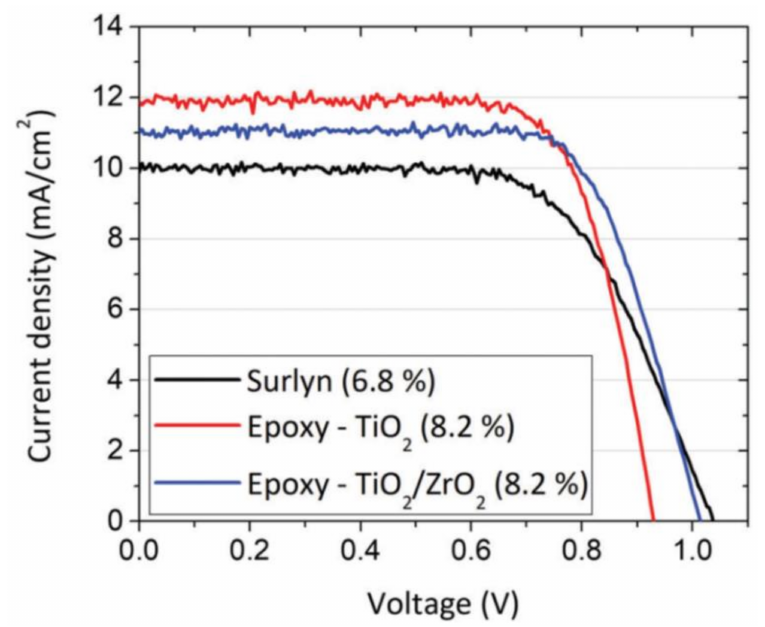
Figure 9. Best JV curves obtained by reducing the inter-electrode distance in the presence of copper redox mediators. Republished with permission of Royal Society of Chemistry, from Ref. [72].